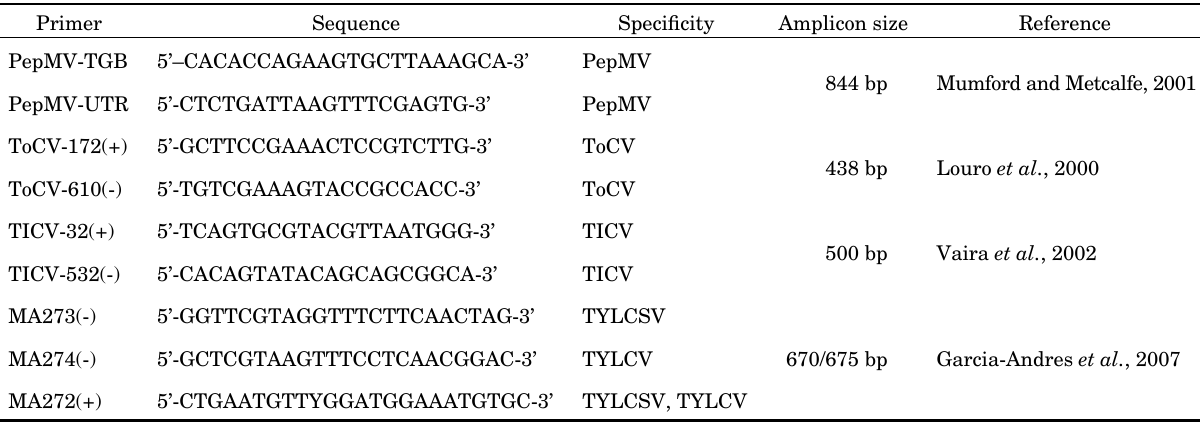
Table 1. Sequence of primers utilized in PCR and RT-PCR analysis for virus detection.